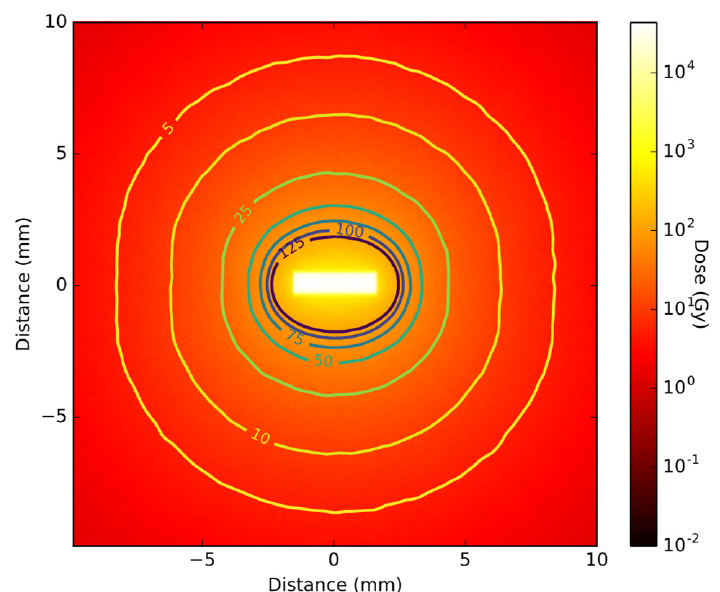
Figure 8. Cross-sectional view of simulated 2D dose distribution of a brachytherapy seed containing nanoparticles with a total 103 Pd activity of 70 MBq. The iso-dose lines show the dose from 5% to 125%.